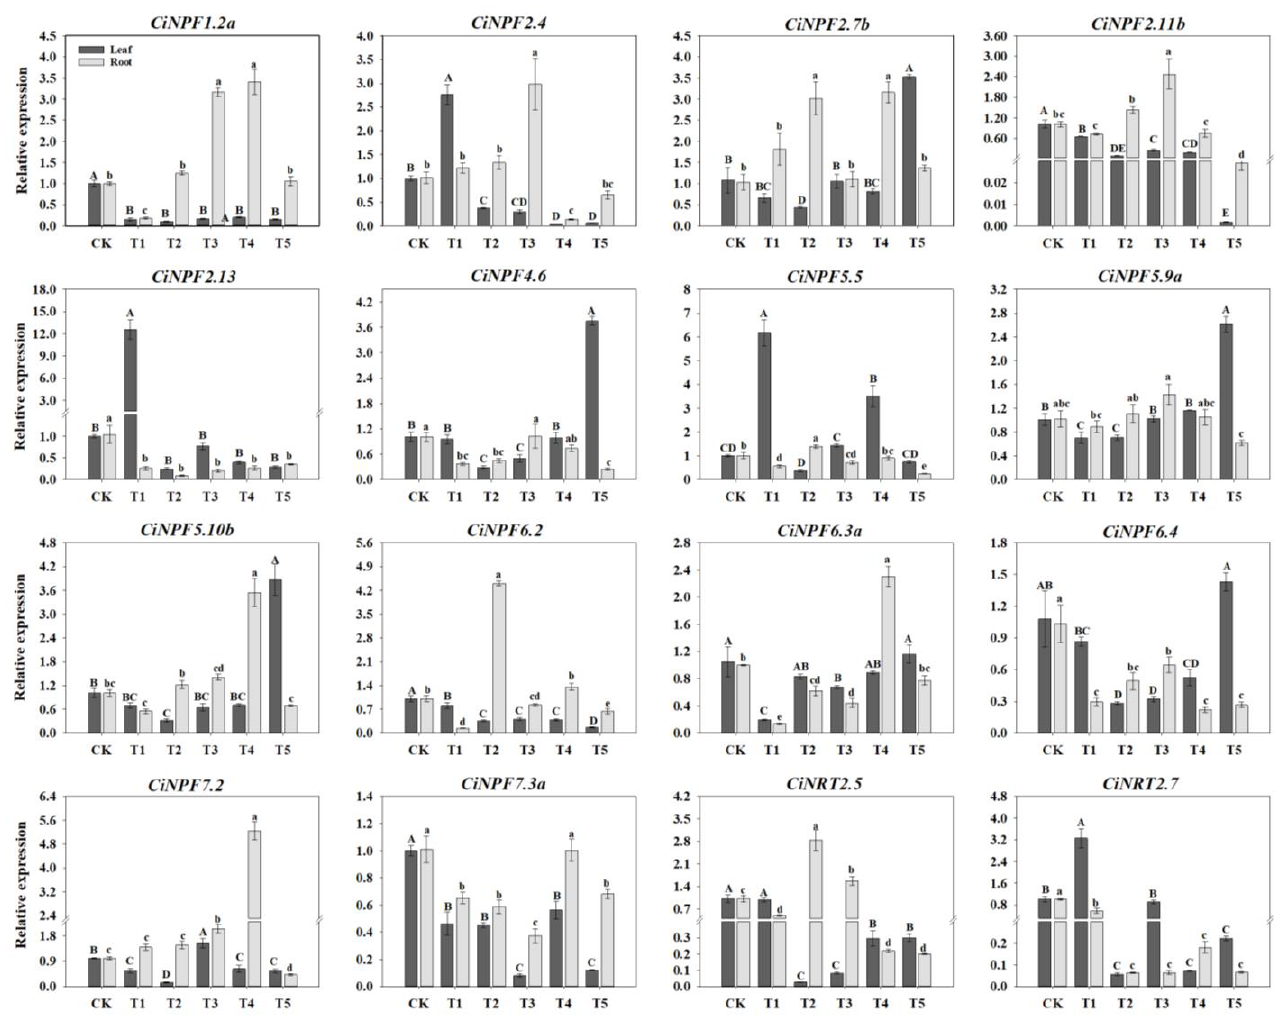
Figure 6. Relative expression of selected pecan CiNRT genes under varying NH 4+ :NO 3 − ratios. The expression levels of selected CiNRT in pecan leaves and roots after varying NH 4+ :NO 3 − ratio treatments were quantified by qRT-PCR, with Actin as the reference gene. Different capital letters indicate significant differences in leaves ( p < 0.05), and different lowercase letters indicate significant differences in roots ( p < 0.05).